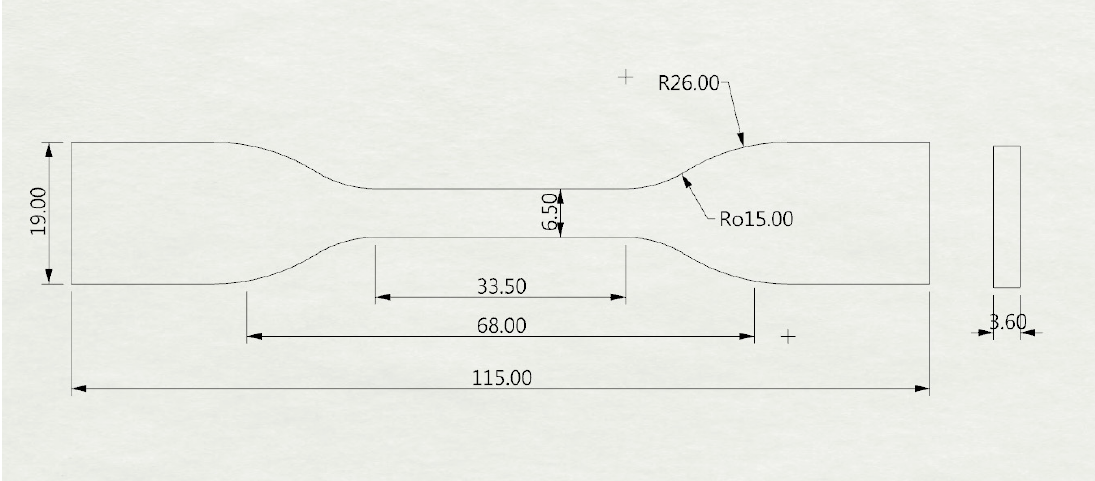
Figure 1. ASTM D638 Type IV.